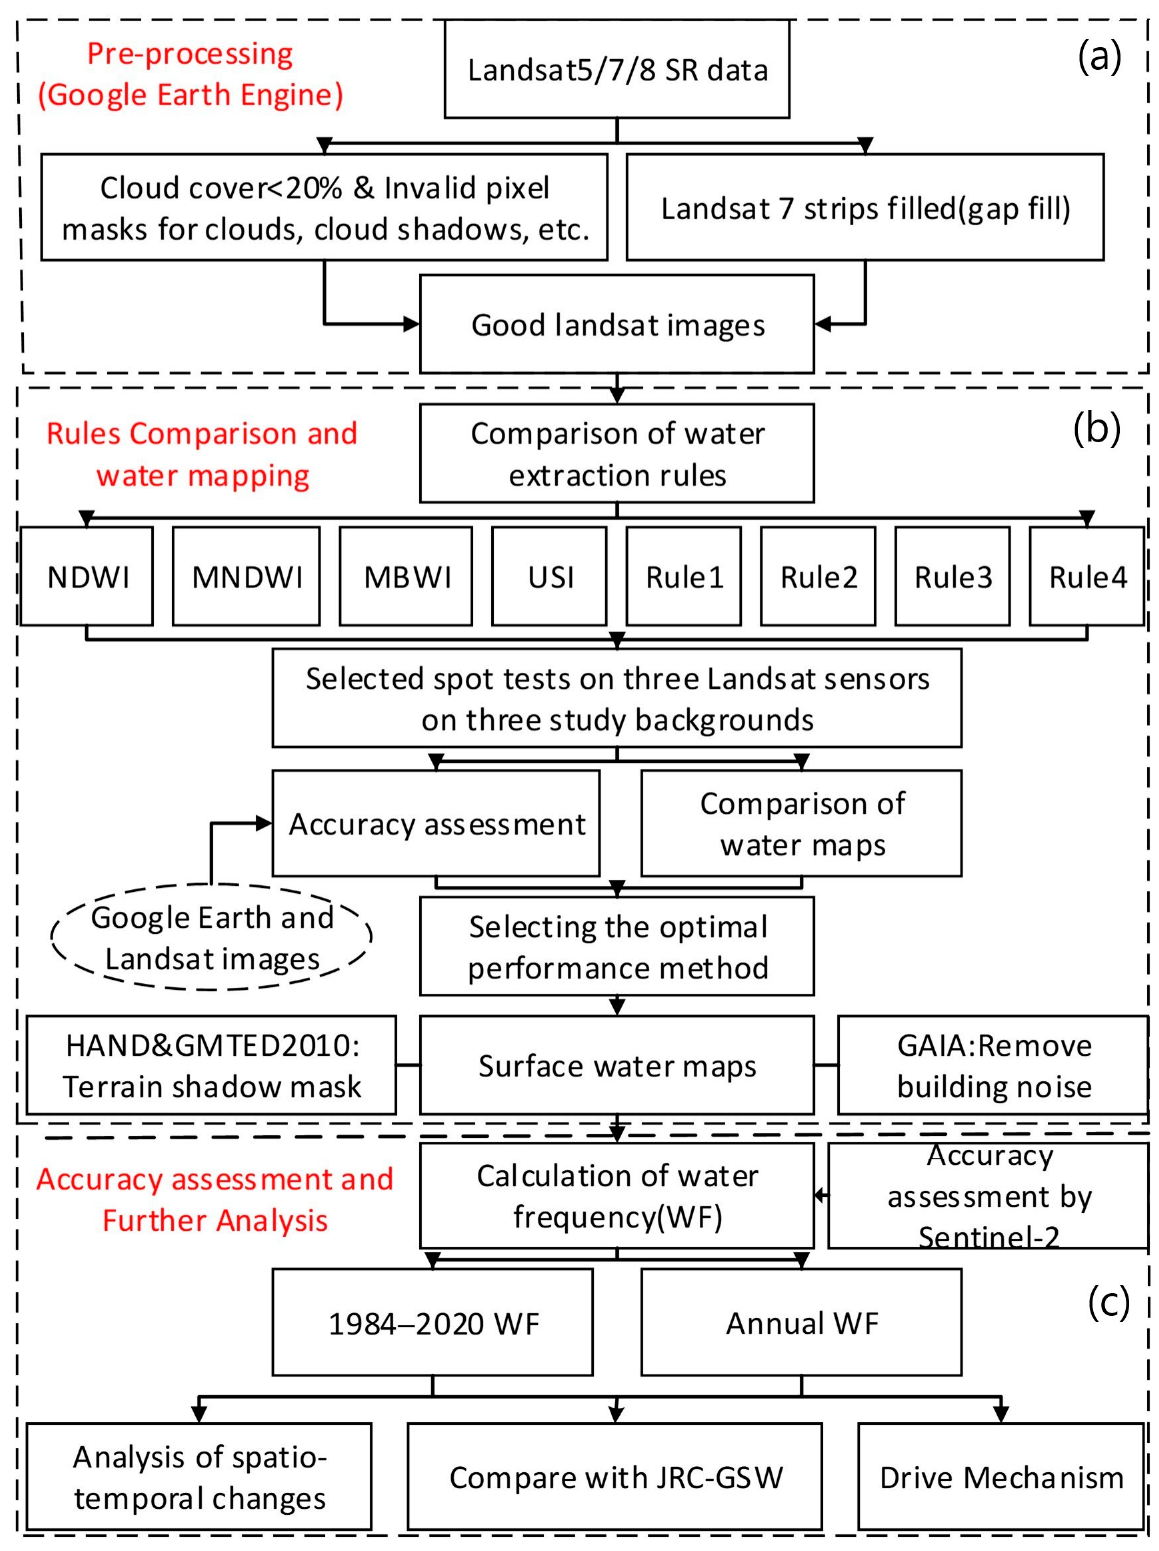
Figure 3. The framework of this